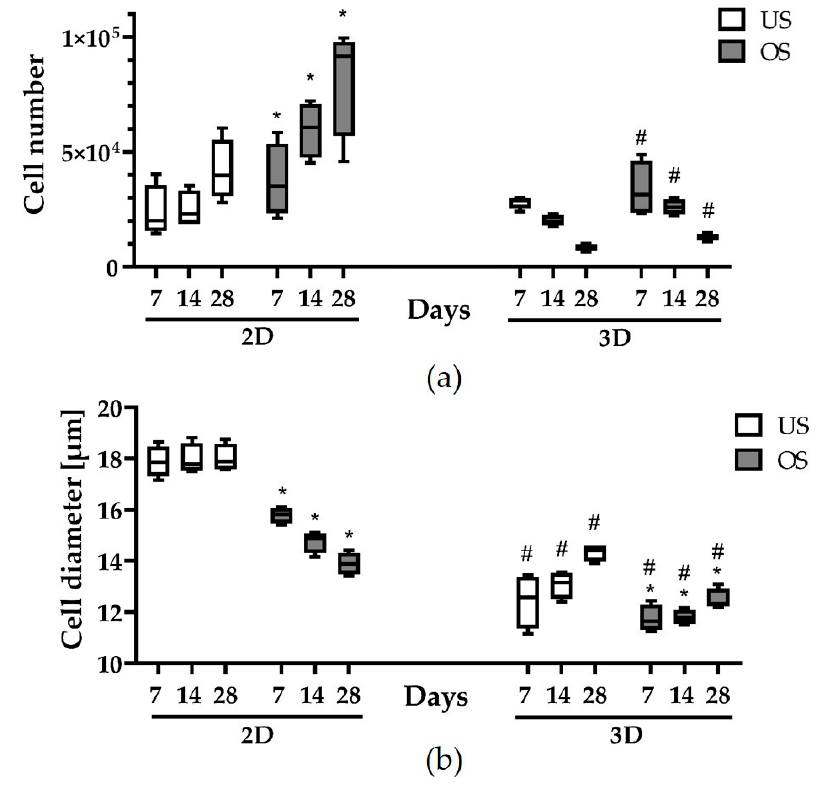
Figure 2. Quantification of the cell number and cell diameter of adMSC in 2D and 3D cultures up to 28 days. ( a ) Cell number of unstimulated (US) and osteogenically stimulated (OS) adMSC over 28 days ( n = 4; * significantly different from the US at the respective time point and dimension (2D/3D), * p < 0.0001; # significantly different from 2D at the respective time point and stimulation (US/OS), two-way ANOVA post hoc uncorrected Fisher’s LSD; # p < 0.0001). ( b ) Diameter of single cells under US and OS conditions in 2D and 3D culture ( n = 4; * significantly different from the US at the respective time point and dimension (2D/3D), * p < 0.05; # significantly different from 2D at the respective time point and stimulation (US/OS), two-way ANOVA post hoc uncorrected Fisher’s LSD; # p < 0.0001).